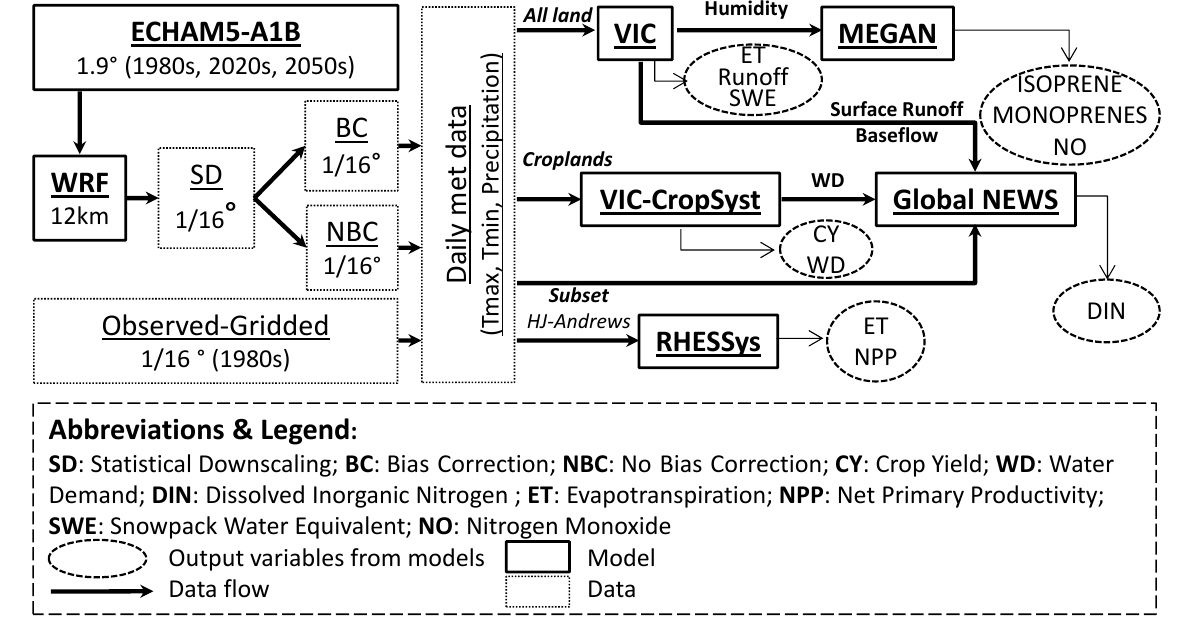
Fig. 2. Offline simulations and data flow for this